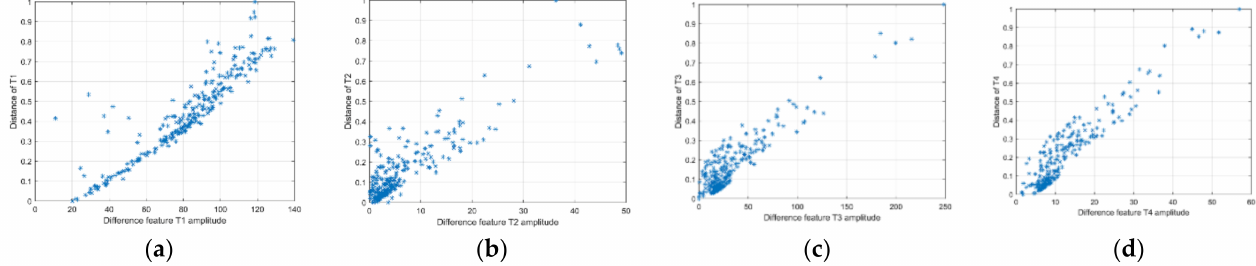
Figure 3. Discrete points figure of the distance of the four types of difference feature. ( a ) difference feature T 1 ; ( b ) difference feature T 2 ; ( c )difference feature T 3 ; ( d )difference feature T 4